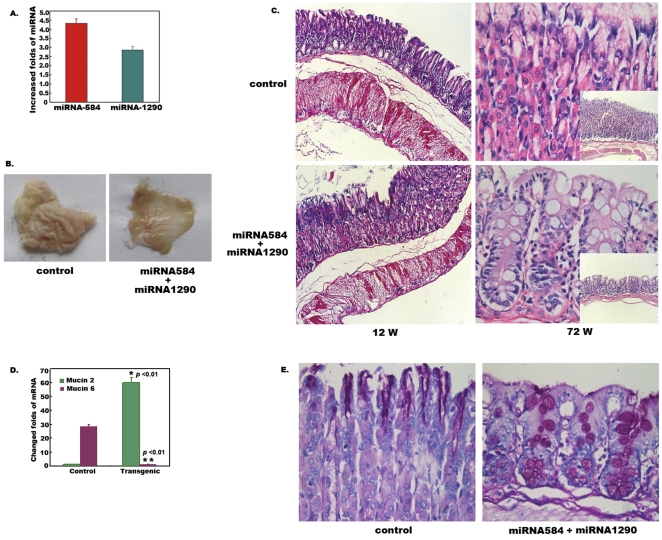
Overexpression of miRNA-584 and miRNA-1290 induced intestinal metaplasia in knock-in mice. A. Determination of miRNA-584 and miRNA-1290 in knock-in mice.Total RNA was extracted from minced tissues of mice by Trizol reagent. Real-time PCR was performed for determination of miRNA-584 and miRNA-1290. The results showed miRNA-584 and miRNA-1290 increased in knock-in mice. Data are represented as mean +/− s.e.m. B. Morphological observation of knock-in mice. Obvious morphological alterations were not observed at the 12th week in knock-in mice. However, gastric mucosa layers were significantly thinned and flattened, and rugal folds had disappeared at the 72nd week C. H&E staining of gastric mucosa. Obvious morphological alterations were not observed at the 12th week in knock-in mice. However, gastric epitheliums were replaced by intestinal metaplasia under light microscopy (×100). D. Determination of
Muc
 2 and
Muc
 6. Total RNA was extracted from minced gastric tissues of mice by Trizol reagent. Real-time PCR was performed for determination of Muc2 and Muc6. The results showed Muc2 was significantly increased while Muc6 was significantly decreased in transgenic mice (all P <0.01, ANOVA). Data are represented as mean +/−s.e.m. E. PAS staining. Gastric mucosa from transgenic mice at 72nd W were checked by PAS staining (×100). The results showed that PAS-positive cells were increased in in transgenic mice.